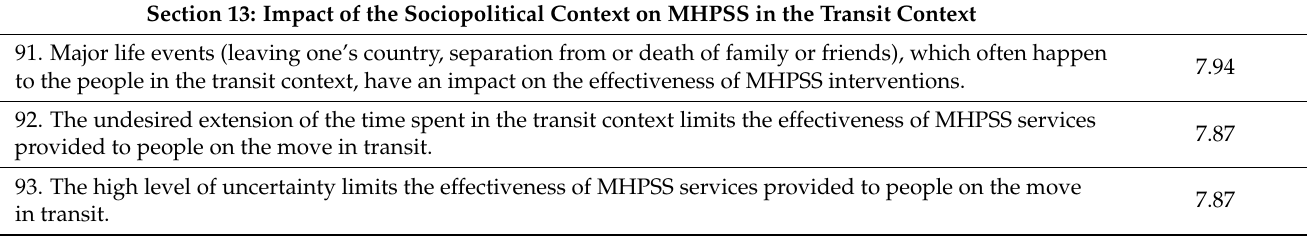
Section 13: Impact of the Sociopolitical Context on MHPSS in the Transit